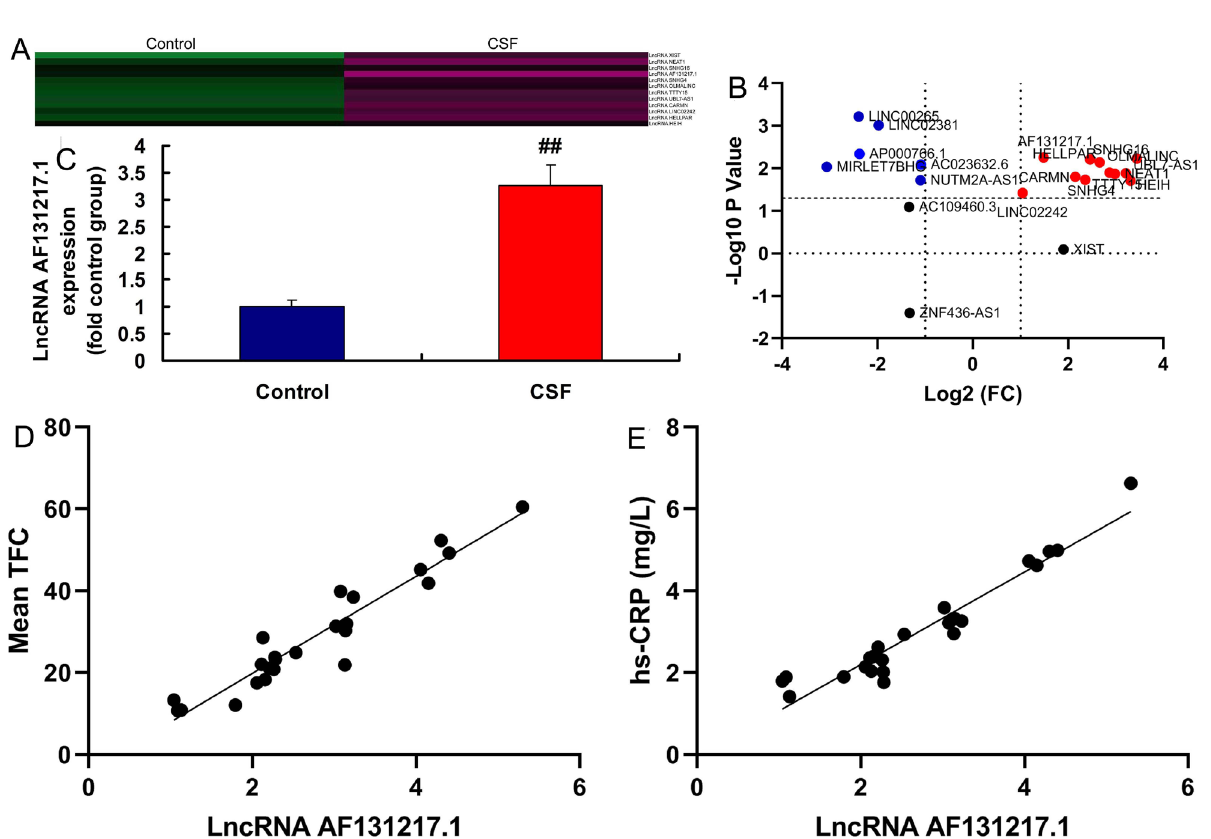
Fig. 1 - Long noncoding ribonucleic acid (lncRNA) AF131217.1 expression in the coronary slow flow (CSF) model. Heat map and volcano figure of gene chip (A and B), quantitative real-time polymerase chain reaction of lncRNA AF131217.1 expression (C) in the CSF model. The mean thrombolysis in myocardial infarction frame count (TFC) was positively correlated with lncRNA AF131217.1 levels (D) and high-sensitivity C-reactive protein (hsCRP) levels (E). Control, normal volunteer group; hsCRP, hsCRP patients group. ## P<0.01 compared with normal volunteer